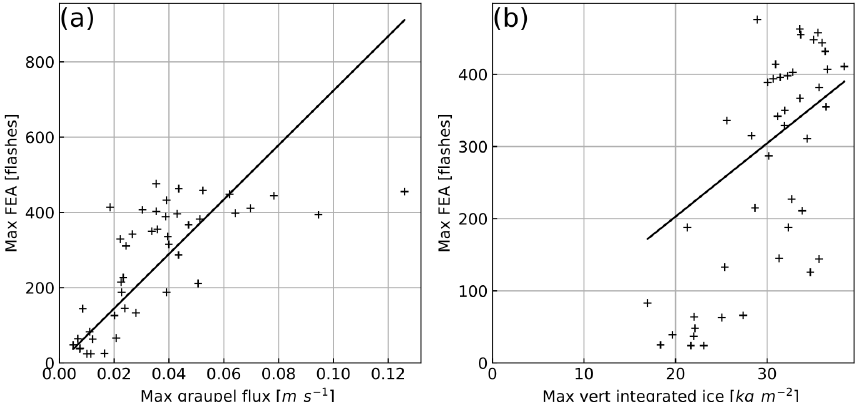
Figure 15. Domain-wide maximum observed FEA versus (a) simulated F1 and (b) simulated F2 with regression curves obtained with the reduced major-axis regression technique.